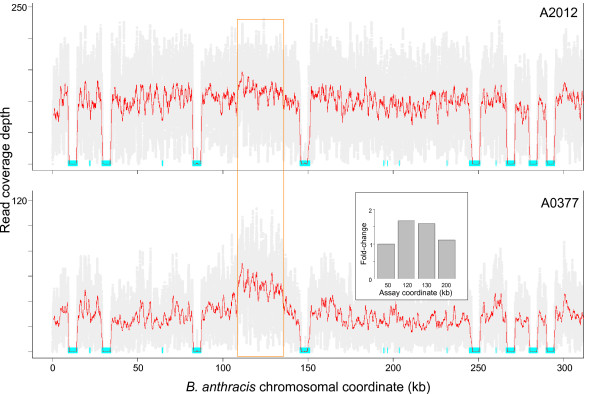
Validation of a strain-specific copy number variant in B. anthracis A0377. Unique coverage near the left end of (top) the A2012 and (bottom) A0377 chromosomes, is depicted as described in Figure 1. The orange box indicates the approximate boundaries of the amplified region in A0377. The eight large cyan bars correspond to the first eight rRNA loci in the genome, which are nearly identical to each other. TaqMan® assays were designed, two internal to the amplified region and one to each side, with the approximate coordinates indicated on the X axis of the inset (in kb). These assays were run in triplicate on genomic DNA from each of the two strains, and relative fold-change of A0377 versus A2012 was calculated and normalized to the assay at coordinate 50 kb (inset).